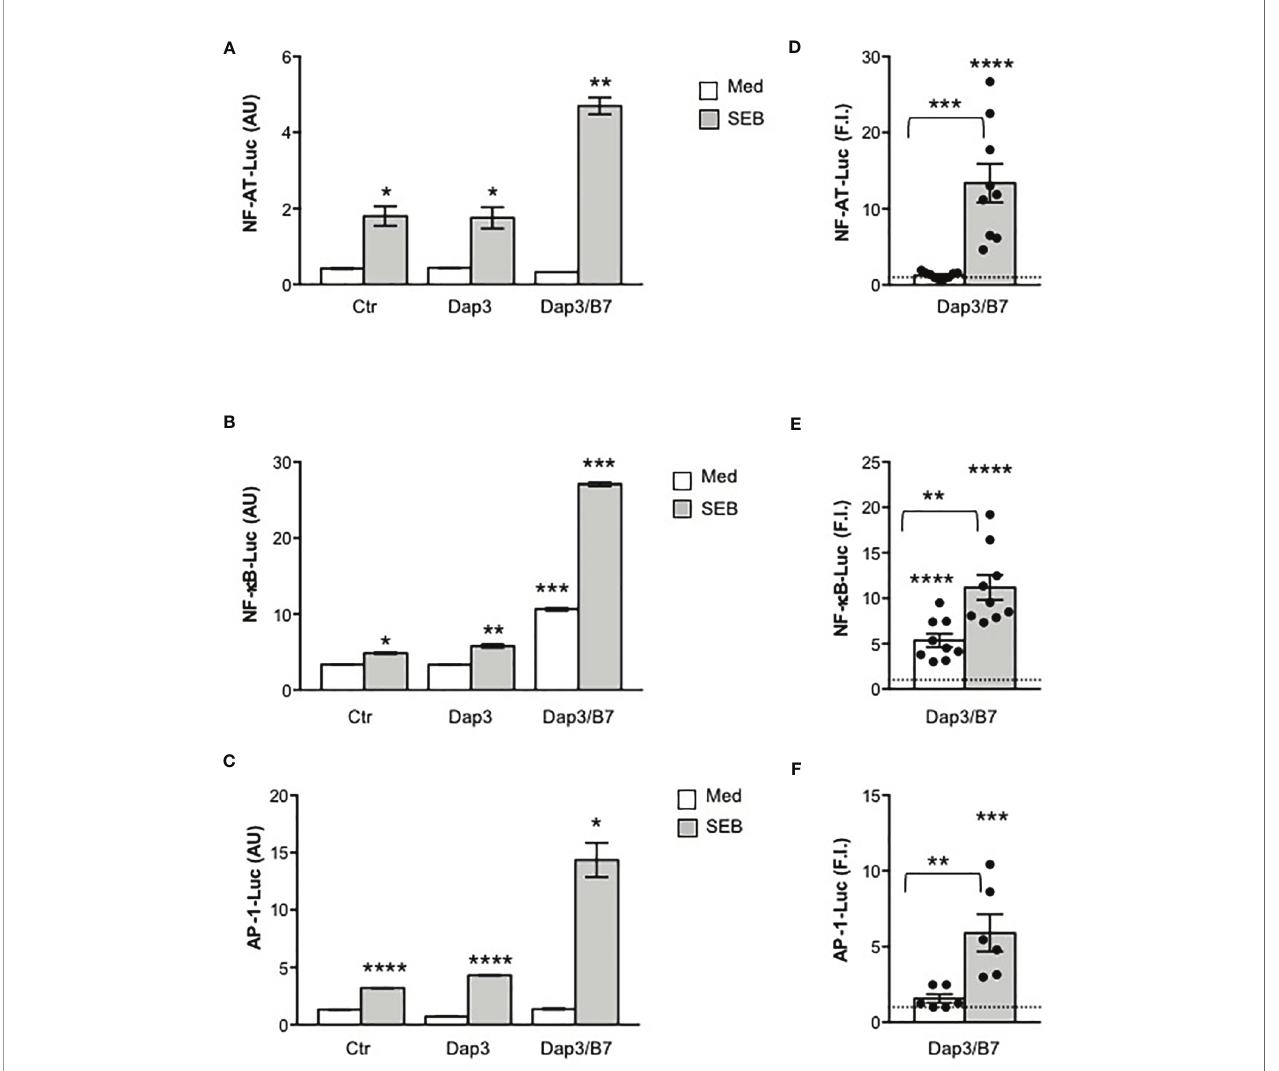
FIGURE 2 | Stimulation of CD28 by SEB induces transcription factor activation in the absence of MHC class II molecules. (A – F) CD28WT cells transfected with 5 µg GFP together with 10 µg NF-AT-luciferase (A, D) , or 2 µg NF- k B-luciferase (B, E) or 10 µg AP-1-luciferase constructs (C, F) were unstimulated (Ctr) or stimulated for 6 hours with SEB (1 m g ml -1 ) alone or in the presence of Dap3 or Dap3/B7 cells. The results (A – C) are expressed as the mean of the luciferase units (AU) ± SEM after normalization to GFP expression and are representative of three independent experiments. (D) NF-AT luciferase activity (n = 9), (E) NF- k B luciferase activity (n = 9) and (F) AP-1-luciferase activity (n=8) of CD28WT cells stimulated with Dap3/B7 in the presence or absence of SEB. Bars show the mean fold induction (F.I) ± SEM after normalization to GFP values. Statistical signi fi cance was calculated by Student ’ s t test. Mean values: NF-AT, Dap3/B7 = 1.2, Dap3/B7 SEB = 13.3; NF- k B, Dap3/B7 = 5.3, Dap3/B7 SEB = 11.1; AP-1, Dap3/B7 = 1.5, Dap3/B7 SEB = 5.9. (*) p < 0.05, (**) p < 0.01, (***) p < 0.001, (****) p <